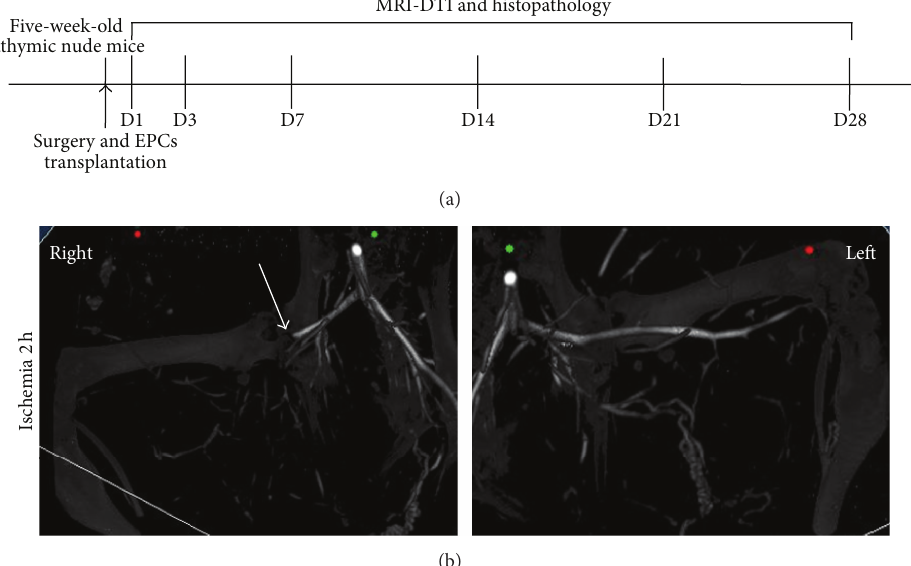
Figure 4: Diagram of the EPCs tracking and treatment evaluation methods (a); representative imaging of micro-CT (b) performed after development of hindlimb ischemia 2 hour. The proximal origin of the right femoral artery was terminated